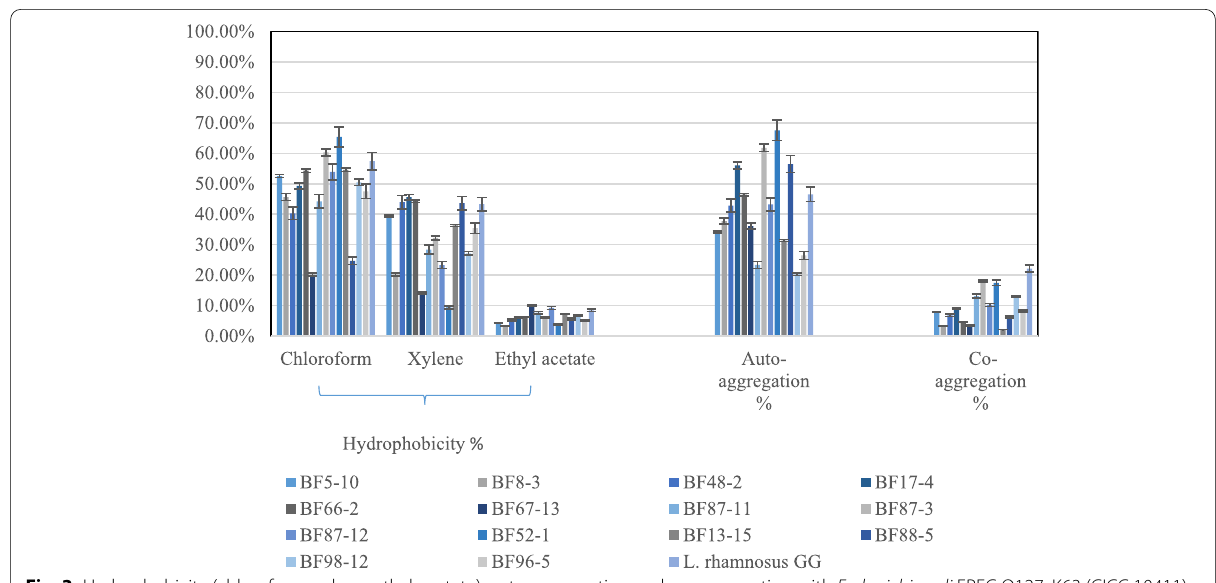
Fig. 3 Hydrophobicity (chloroform, xylene, ethyl acetate), auto-aggregation and co-aggregation with Escherichia coli EPEC O127: K63 (CICC 10411) percentage of the Bifidobacterium strains. (Error bars indicate standard deviation from three independent experiments)